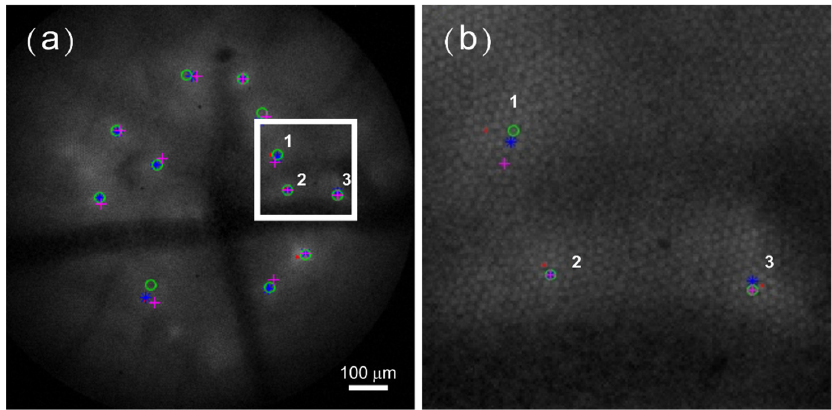
Figure 4. Matching active centers. ( a ) All matched active centers are marked for the four frames shown in Figure 3. The region highlighted by the white square includes three of the 12 matched active centers. ( b ) Zoom-in view of the square region-of-interest in Figure 4a. Markers of four types denote the active centers found in each of the four images (red dots for the 1 st image; green circles for the 2 nd ; magenta crosses for the 3 rd ; blue asterisks for the 4 th ).